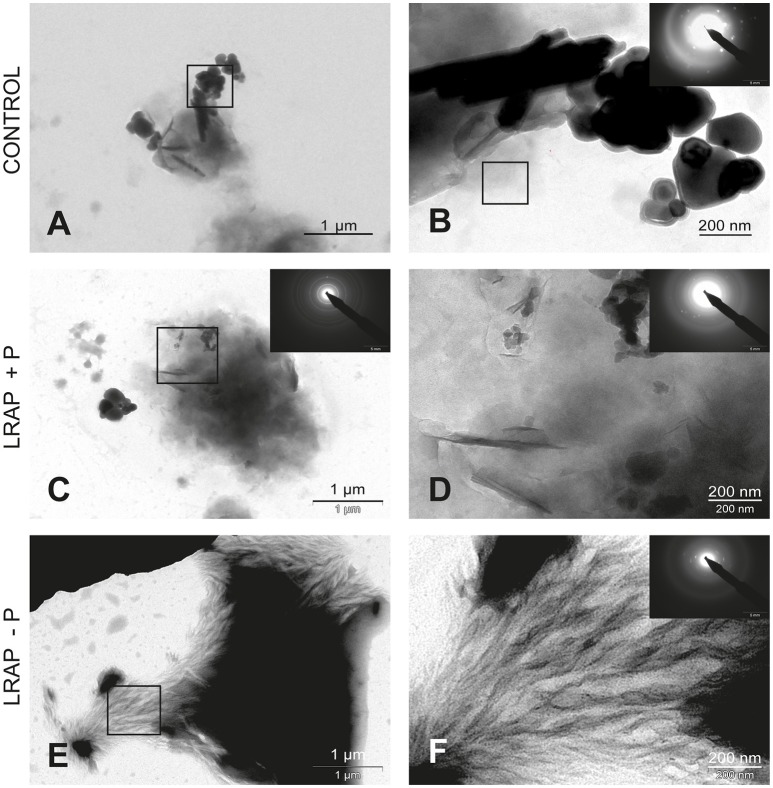
TEM and SAED analyses of mineral phases formed under mineralizing conditions by the ALC cells in the absence and presence of added peptide. (A,B) CONTROL, no added peptide; (C,D) LRAP(+P); and (E,F) LRAP(–P). In (A,C,E), general crystal distribution can be observed, crystal characterization is presented in (B–D,F). Very large round and elongated HAP crystals are present in the control (A,B). Upon addition of LRAP(+P) (C,D) and LRAP(–P) (E,F), needle-like HAP crystals were formed with LRAP(–P) potentiating, bundle formation.